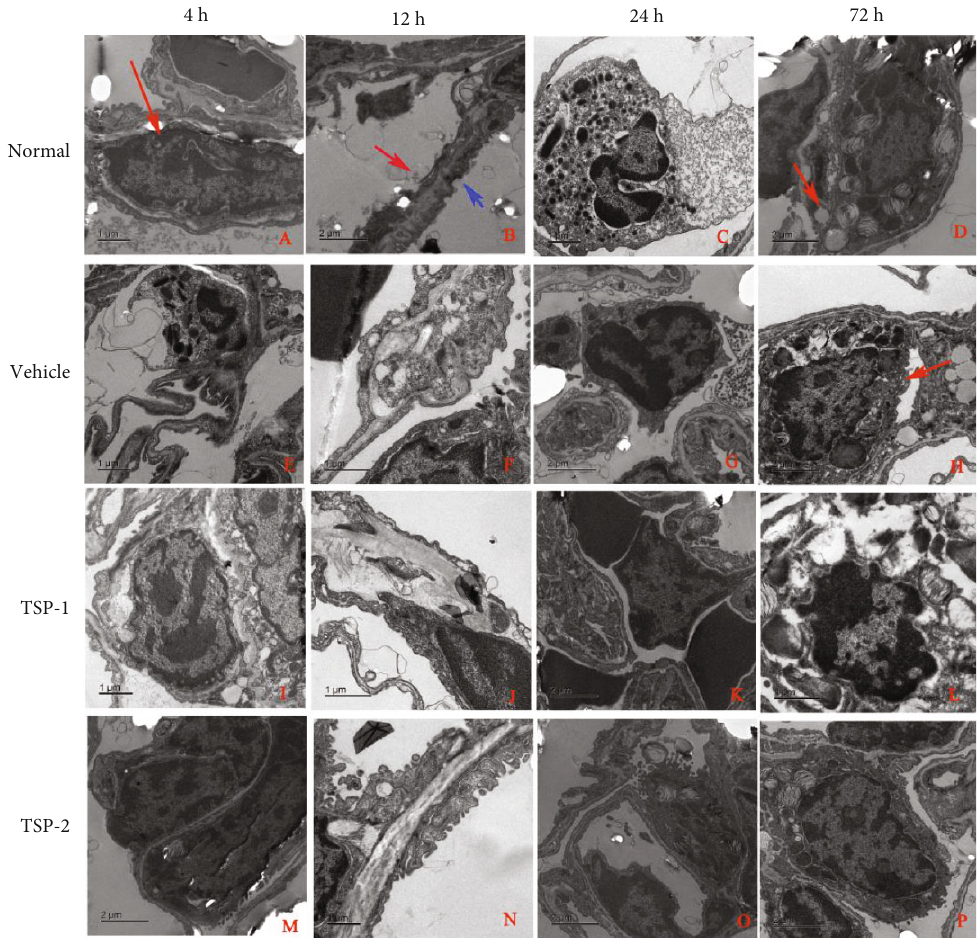
Figure 8: Ultrastructural morphology after TSP-2 overexpression in the ARDS mouse model. Mouse tissue sections from normal mice or mice treated with LPS for 4, 12, 24, and 72h and overexpressing either empty vector (vehicle group), TSP-1 (TSP-1 group), or TSP-2 (TSP-2 group) were analyzed for ultrastructural morphology using electron microscopy. (a – d) Ultrastructure of pulmonary capillaries under normal conditions. Arrow in (a) shows normal blood vessel epithelial cells (ECs), blue arrow in (b) shows the side of the bronchium, and the red arrow shows the side of the capillary at the air-blood barrier having a continuous thin basement membrane. (c) Macrophages within the blood vessel. Arrow in (d) shows alveolar epithelial cells (AECs) with clear lamellar bodies. (e – h) Electron micrographs in the vehicle group demonstrated disruption of the basement membrane in capillaries (e); thickened air-blood barrier (f); perivascular edema and in fl ammatory cell in fi ltration (g); and an apoptotic AEC with visible empty lamellar bodies, swollen cell organs, and contracted nuclei with condensed and fragmented nuclear chromatin (arrow) (h). (i – l) Ultrastructural morphology of EC (i), thickened air-blood barrier (j), perivascular edema (k), and apoptotic AEC (l) in the TSP-1 overexpression group, which was similar to the vehicle group. (m – p) Depiction of normal ultrastructural morphology of EC (m), AEC (p), air-blood barrier (n), and alleviated perivascular edema (o) in the TSP-2 overexpression group. The scale bars in (a, c, e, f, i, j, l, and n) are 1 μ m; the scale bars in (b, d, g, h, k, m, o, and p) are 2 μ m ( n = 5 per